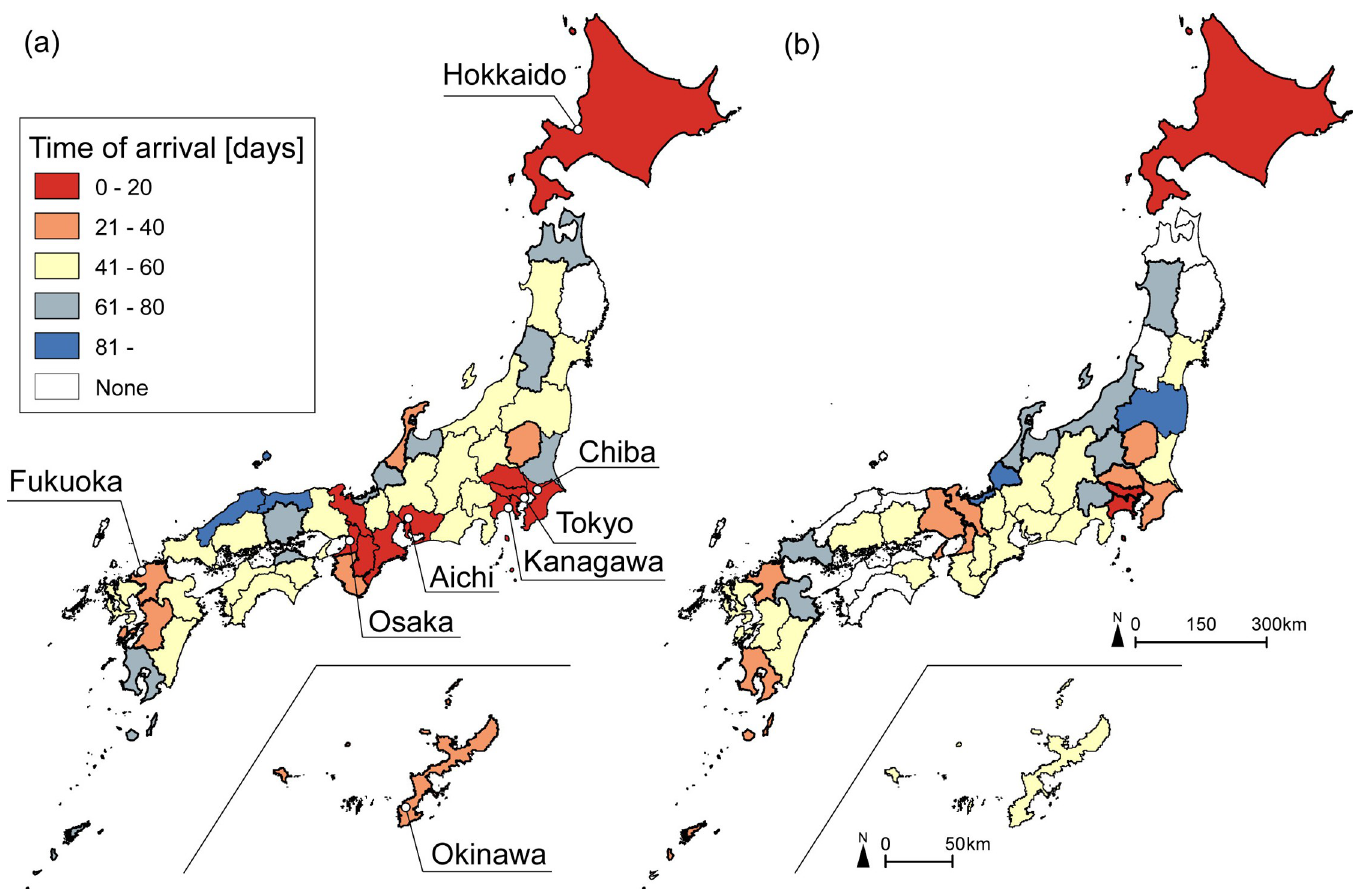
Fig 2. Time of arrival of 1 st epidemic wave and 2 nd epidemic wave. (a) No. of cases at 1 st epidemic wave (January 16 to May 24). (b) No. of cases at 2 nd epidemic wave (May 25 to August 30). Time of arrival of the virus in each prefecture is shown in S2